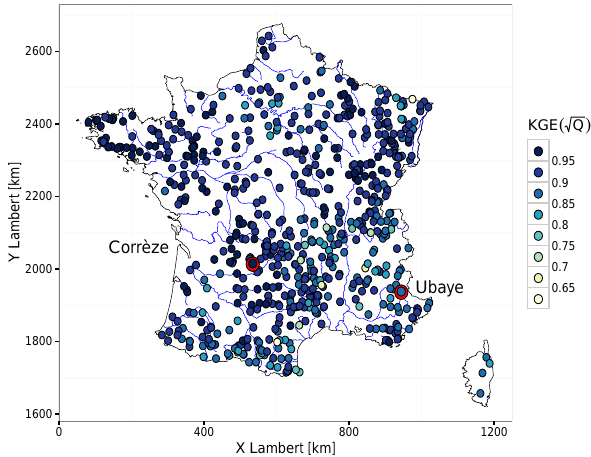
Figure 2. Location of the 662 hydrometric stations, and the KGE calibration score for the hydrological model. The ideal value of the KGE is 1. Red circles highlight the two case study catchments: the Corrèze@Brive-la-Gaillarde (western slope of the Massif Central mountain range) and the Ubaye@Barcelonnette (southern